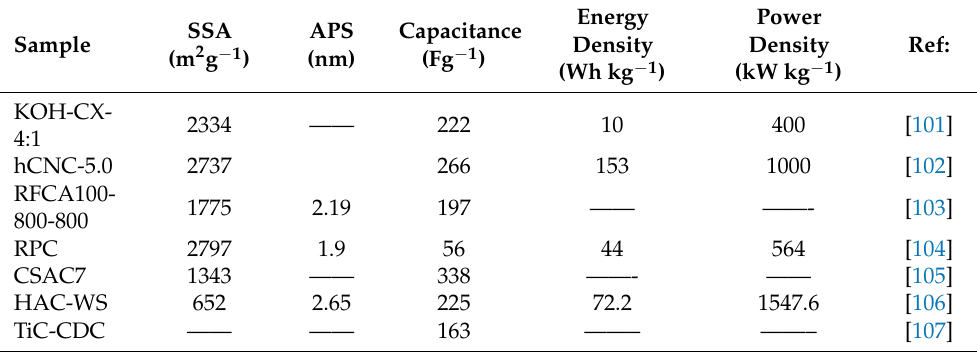
Table 2. The electrochemical performance characteristics of carbon